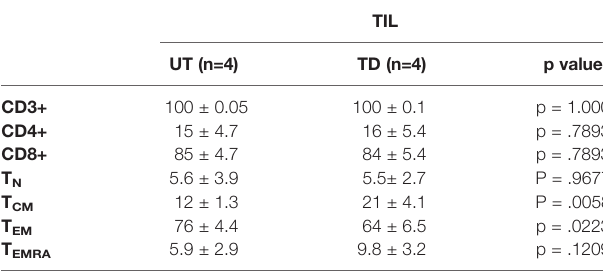
Data is presented as average % expression of the indicated markers. TN (naïve), CD3+ CD45RA+CCR7+; TCM (central memory), CD3+CD45RA − CCR7+; TEM (effector memory), CD3+CD45RA − CCR7 − ; TEMRA (effector), CD3+CD45RA+CCR7 −